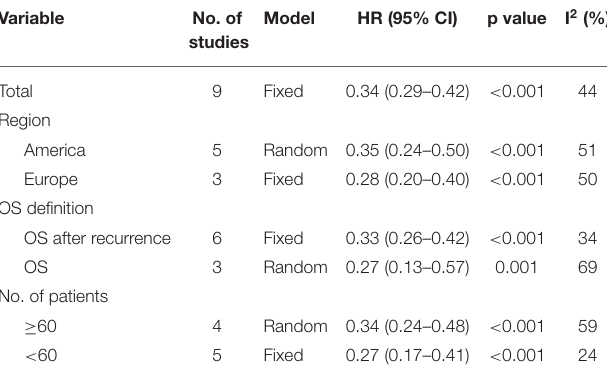
TABLE 2 | Subgroup analysis of reoperation for recurrent ACC based on region, definition of overall survival and number of included patients.